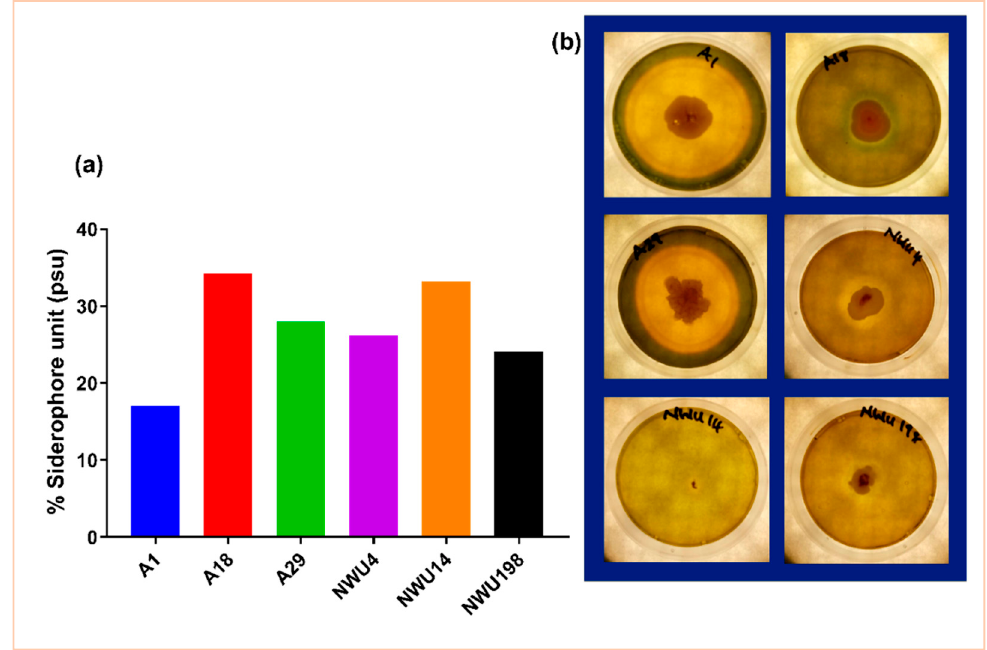
Figure 2. Siderophore production by isolates. ( a ) Mean amount of percentage siderophore unit production in each rhizobacterium. ( b ) Halo zones are seen in siderophore-producing rhizobacteria.